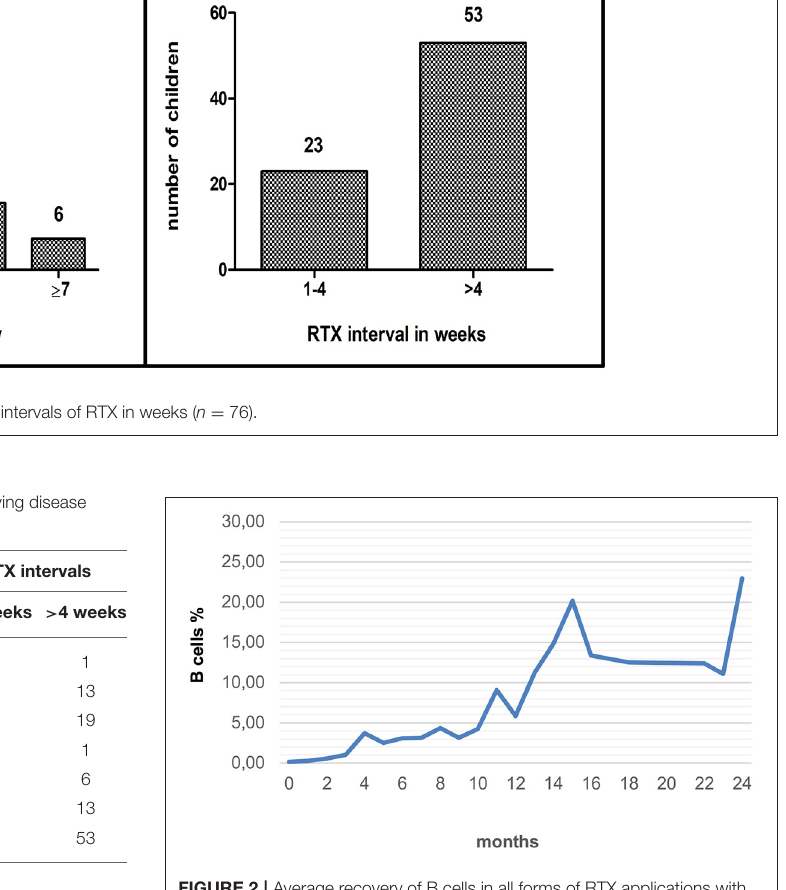
FIGURE 2 | Average recovery of B cells in all forms of RTX applications with long-term monitoring ( n =